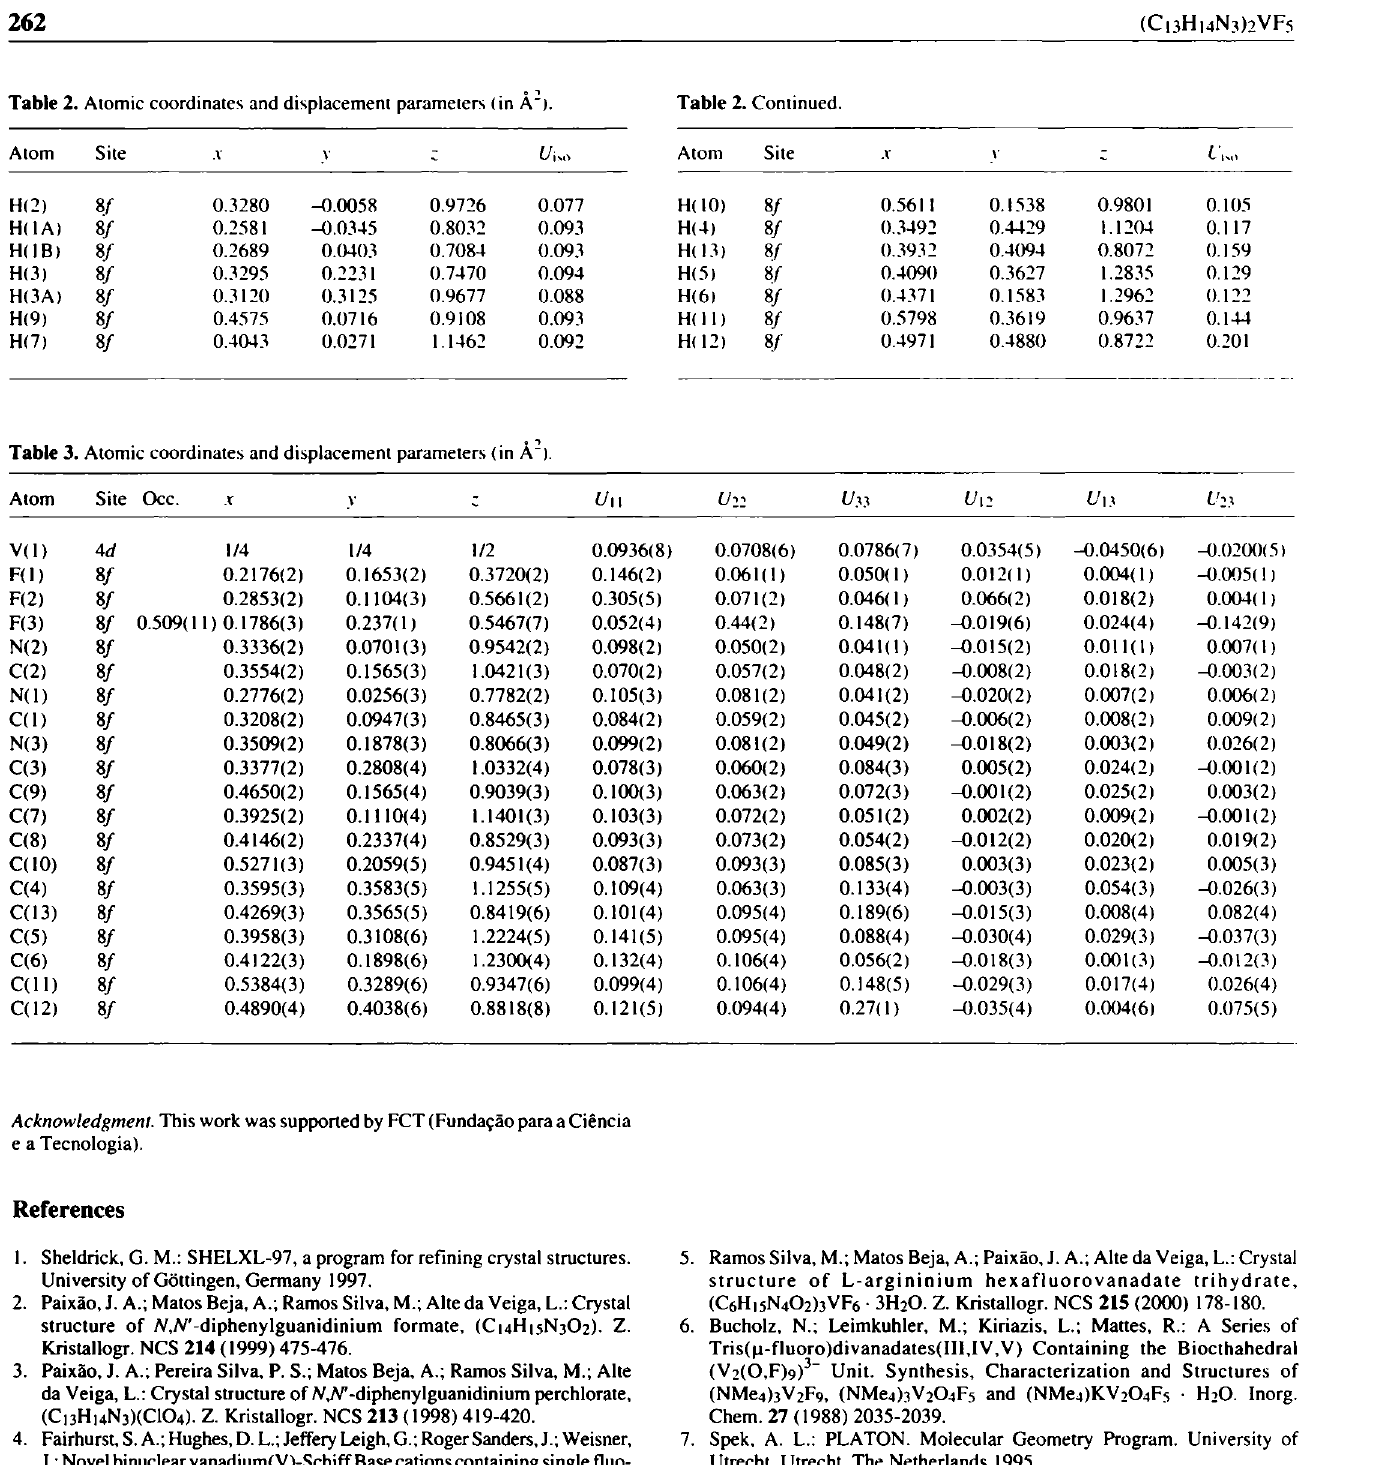
Table 2. Atomic coordinates and displacement parameters (in A").